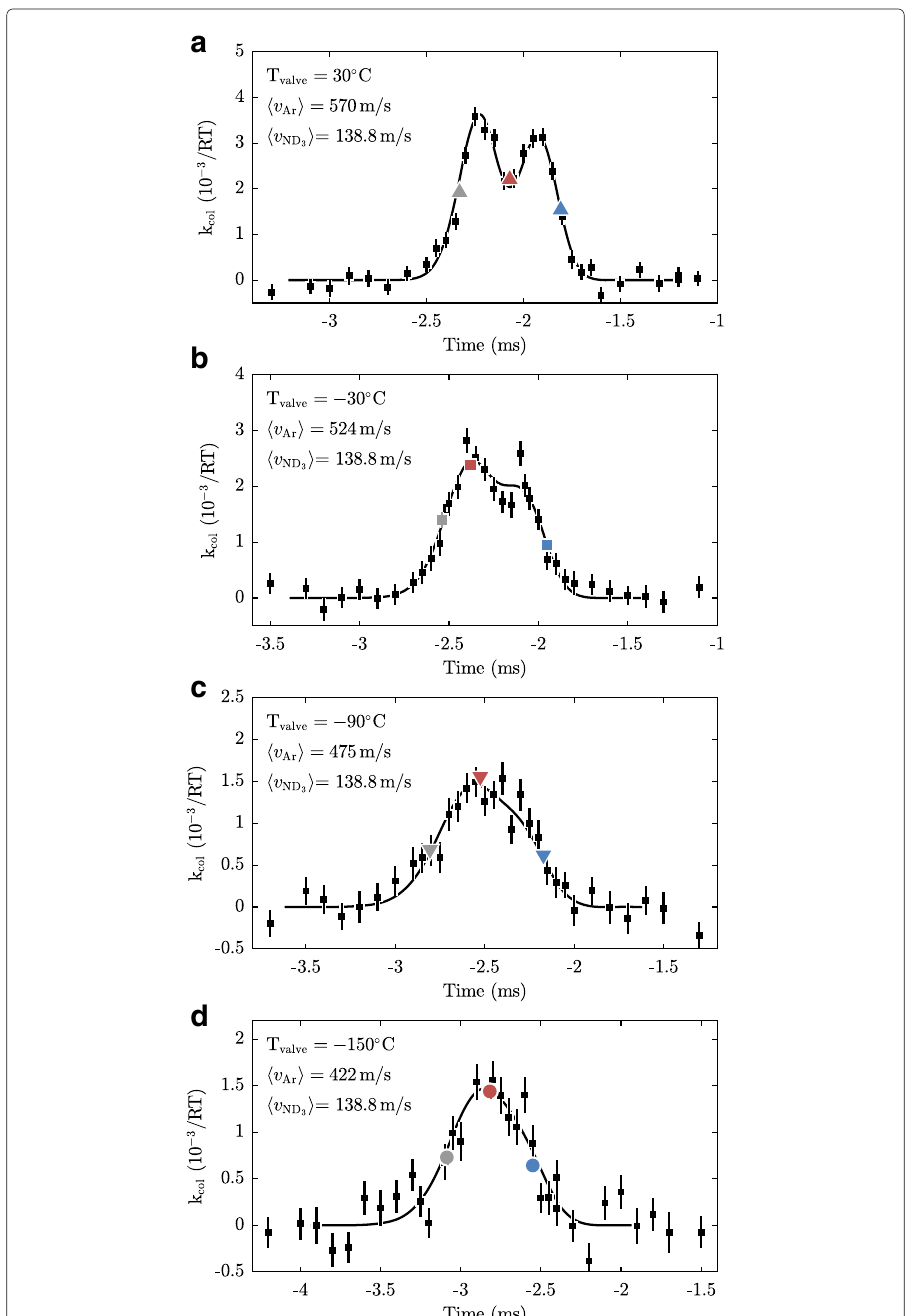
= 138.8 m/s. The reduced χ 2 ’s of the fits are 0.98, 0.89, 0.79, and 1.39 for 3